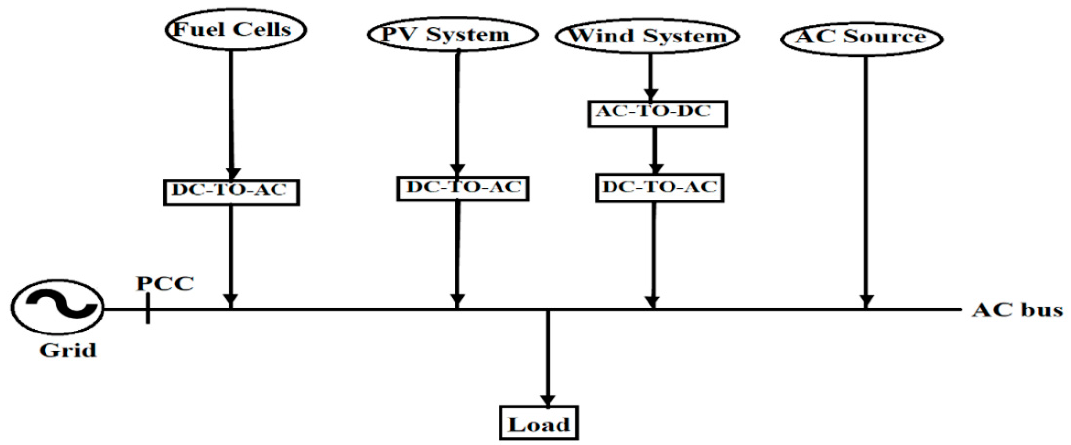
Figure 1. AC Type Microgrid.